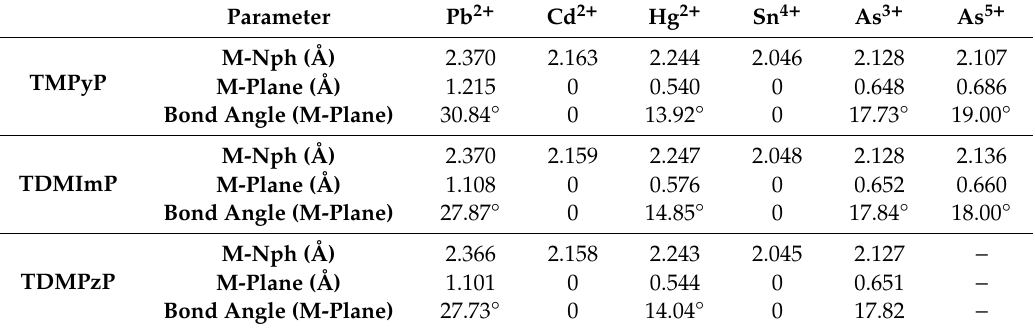
M-NPh: the average bond length of the metal − nitrogen porphyrin. M-Plane: the length of the distance between the metal and porphyrin plane. ∠ M-Plane: the angle between the metal and porphyrin